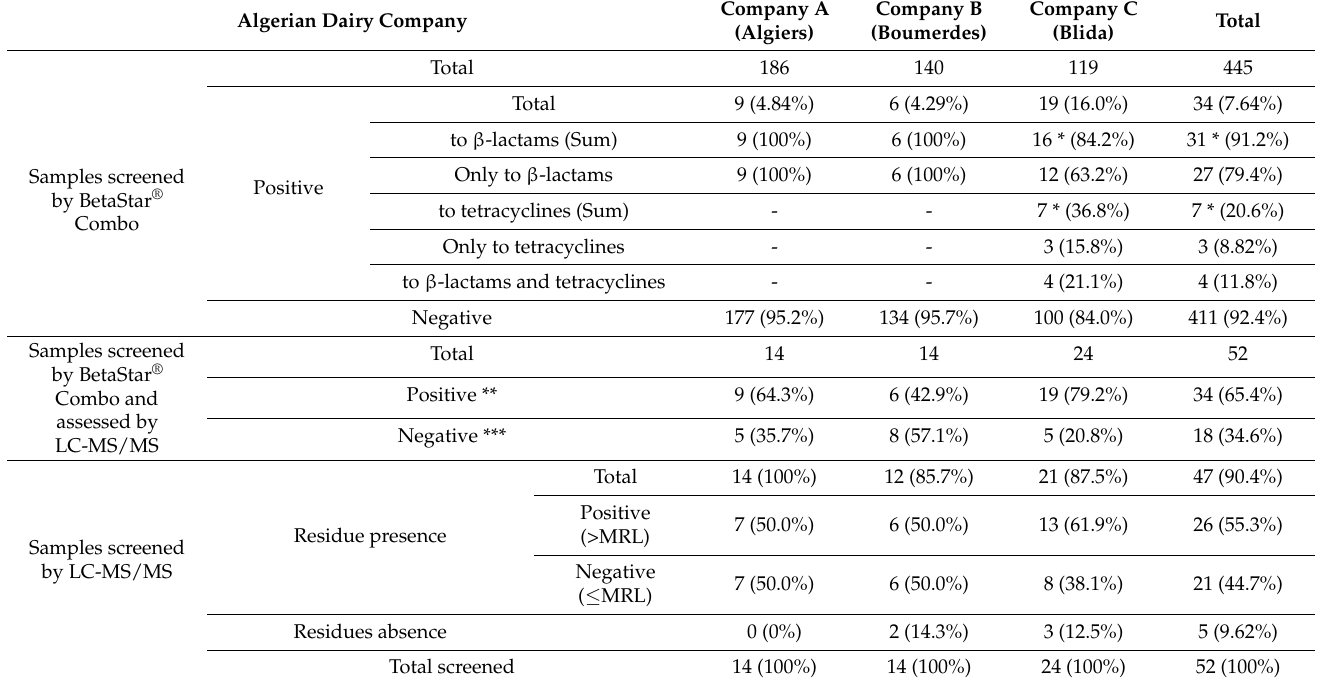
Table 2. Milk samples’ proportions tested positive or negative for antibiotic residues (case number) by BetaStar ®